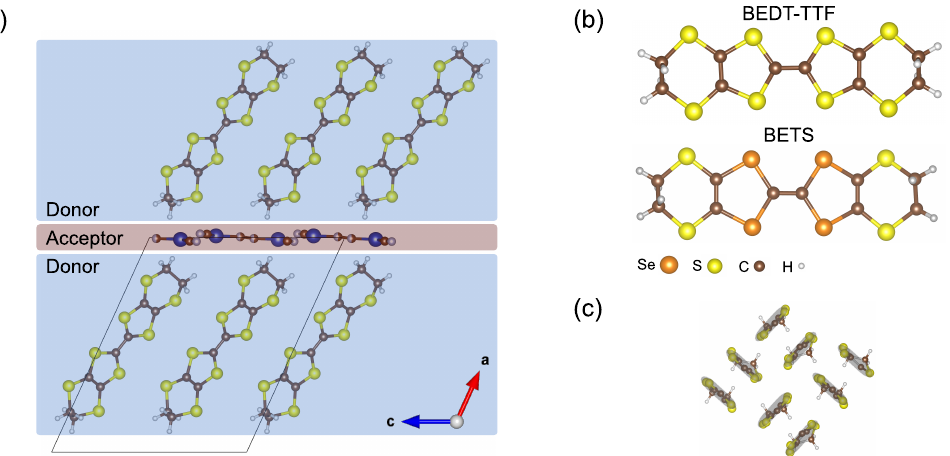
Figure 1. ( a ) Layered structure of organic electron donor and inorganic electron acceptor layer, shown for the example κ -(BEDT-TTF) 2 Cu 2 (CN) 3 ; ( b ) structure of BEDT-TTF and BETS molecules; and ( c ) κ packing motif of the organic layer of κ phase charge-transfer salts from the top view.